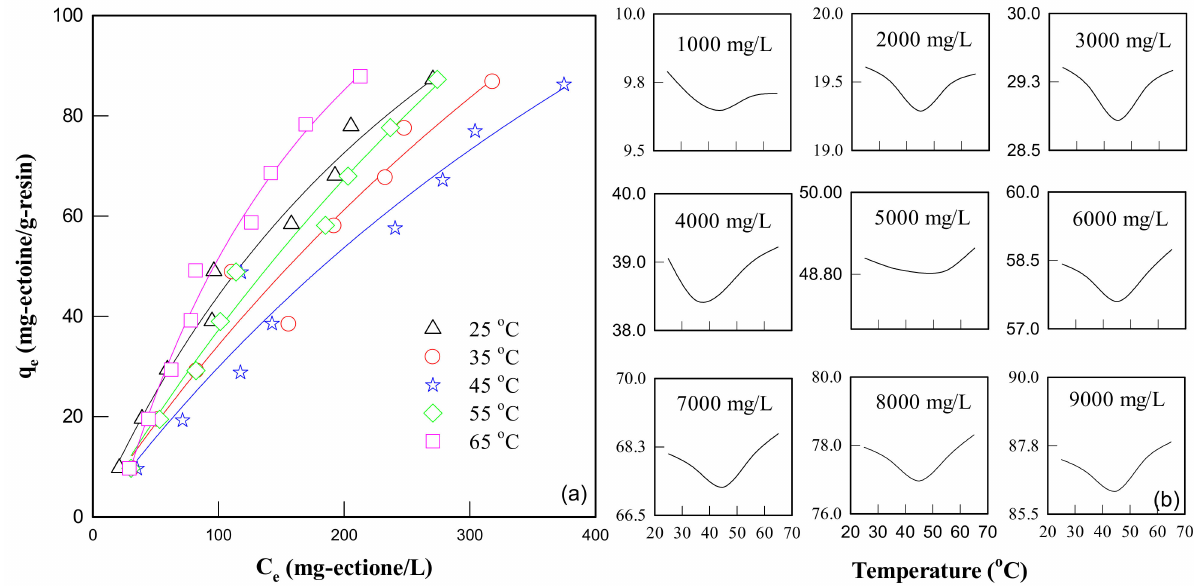
Figure 4. ( a ) Adsorption isotherm of ectoine using Dowex ® HCR-S and ( b ) effect of adsorption capacity of ectoine on temperature at different initial ectoine concentrations (initial ectoine = 1000~9000 mg/L, dry resin/aqueous = 0.1 g/mL, agitated rate = 100 rpm, time = 8 h, temperature = 25~65 ◦